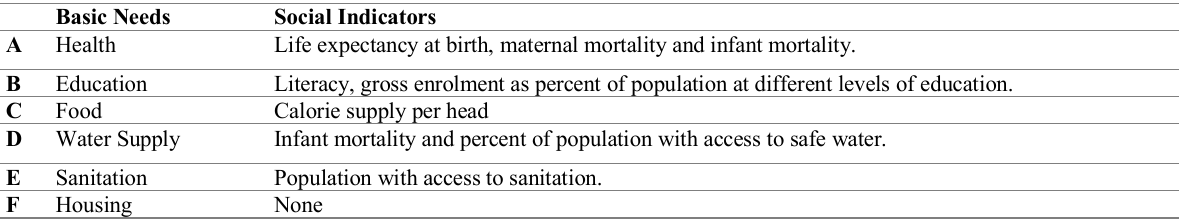
Table 1: Social Indicators for Basic